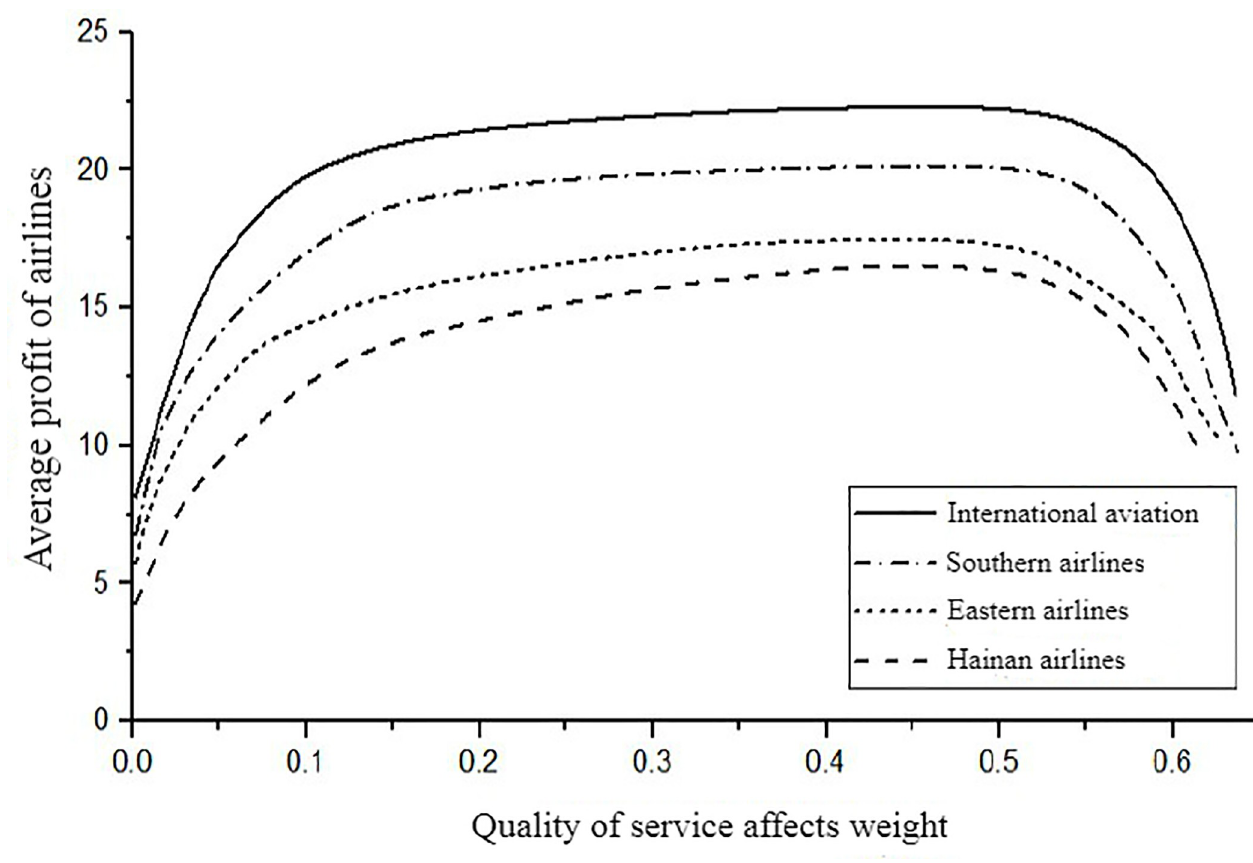
Fig 7. At T = 88, the effect of the β 4 change on average profit.